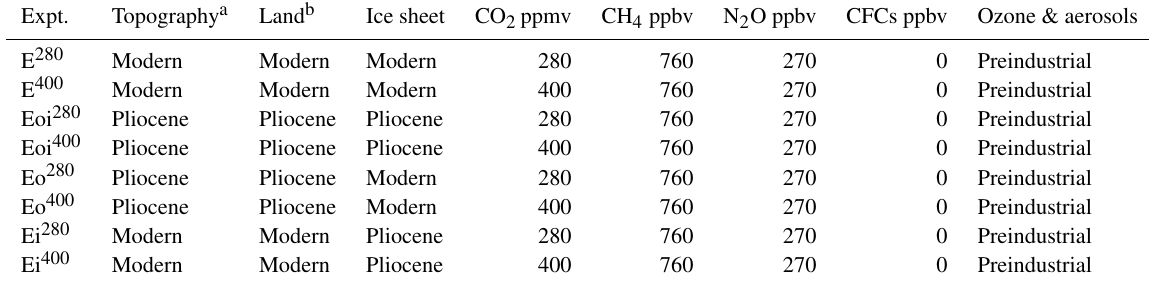
Table 1. Boundary conditions for the control, Pliocene, and sensitivity experiments. The orbital parameters common to all simulations are the solar constant S 0 = 1365Wm − 2 , eccentricity e = 0 . 016724, obliquity (cid:15) = 23 . 446 ◦ , and the longitude of perihelion e ω = 102 . 04 ◦ .